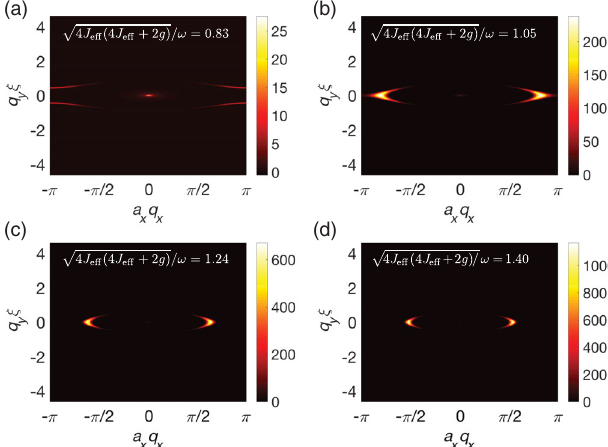
FIG. 18. Quasiparticle momentum distribution function n a duration of t ¼ 10 T , for the 2D band model from Sec. VI B (with a lattice along the x direction and a continuum along the y direction), computed using the linearized dynamics, for different values of the relevant parameter Table II. The suggested ellipses correspond to on-resonance q Þ ¼ π ], which are unstable, while the most unstable modes [ E av ð modes, which are revealed by the main peaks in the momentum distribution, are accurately described by our theoretical predic- tions (see Table